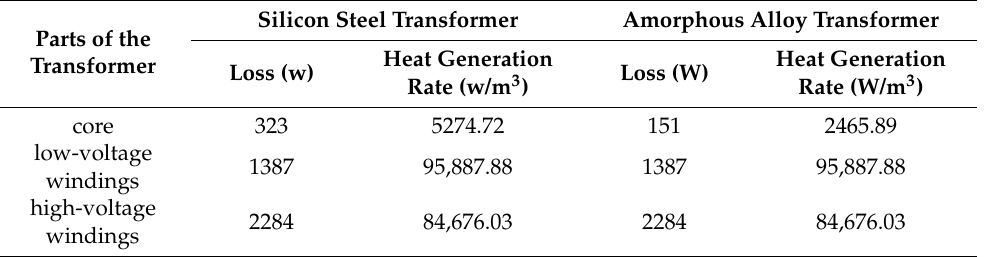
Table 2. Loss and heat generation rate of silicon steel transformer and amorphous alloy motor transformer. Parts of the Transformer